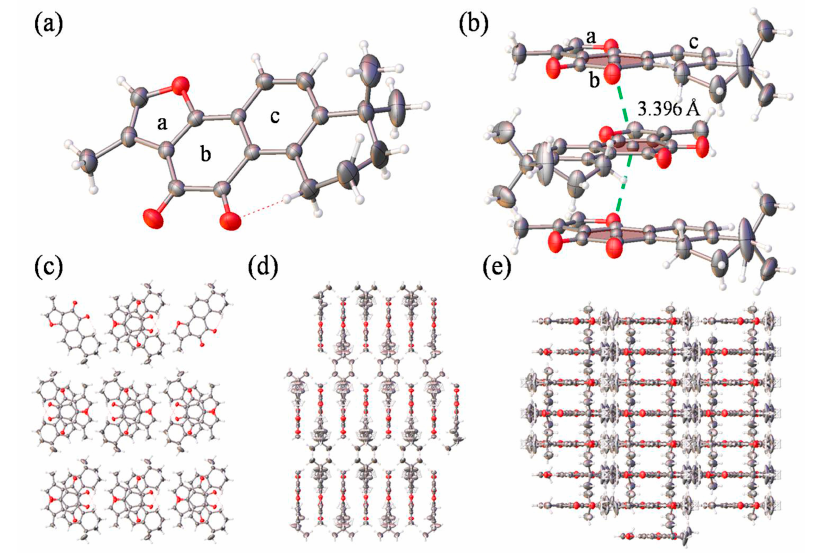
Figure 1. ( a ) The molecular structure of Tan-IIA; ( b ) Stacking interactions in a step showing strong overlap for Tan-IIA. The step showed two benzene rings with a diketone group stacking interactions occurring with distances to the ring centroid of 3.396 Å. The pores viewed along the a axis ( c ), b axis ( d ) and c axis ( e ).